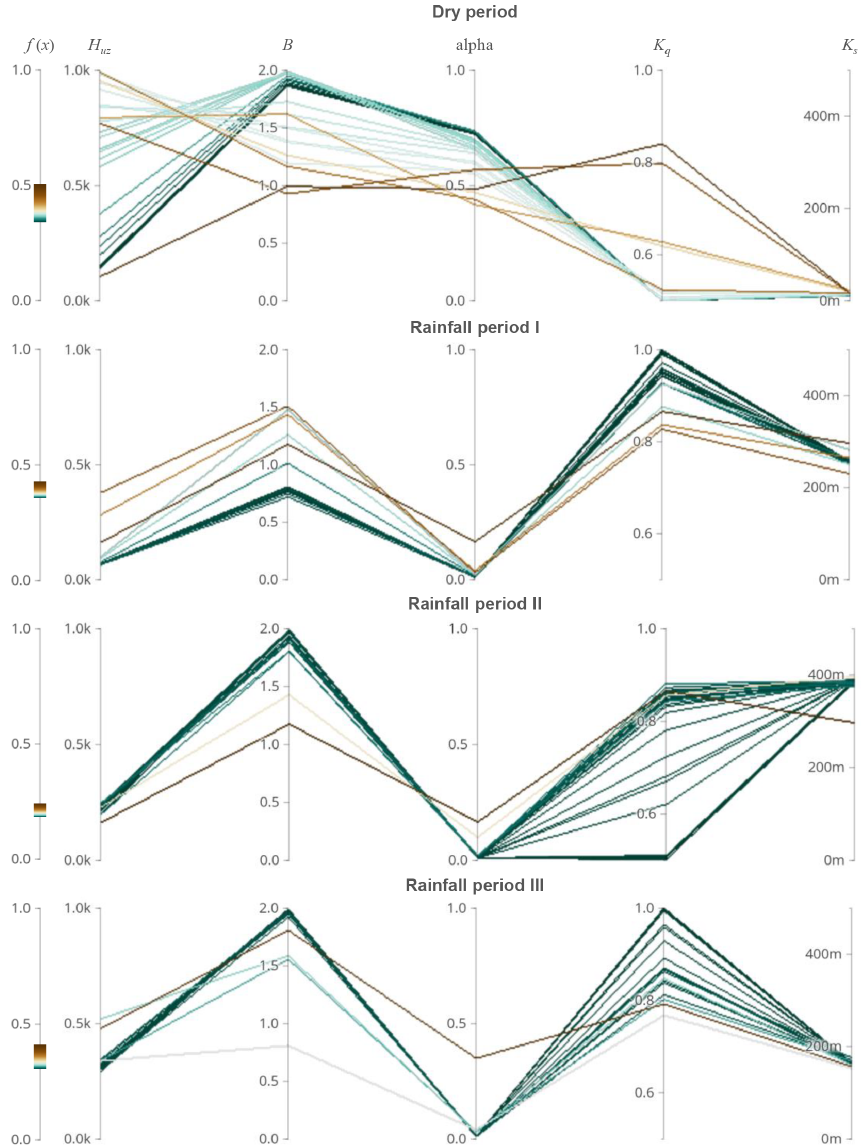
Figure 7. Evolutionary processes of seasonal dynamic parameters in multiparameter space in the Hanzhong